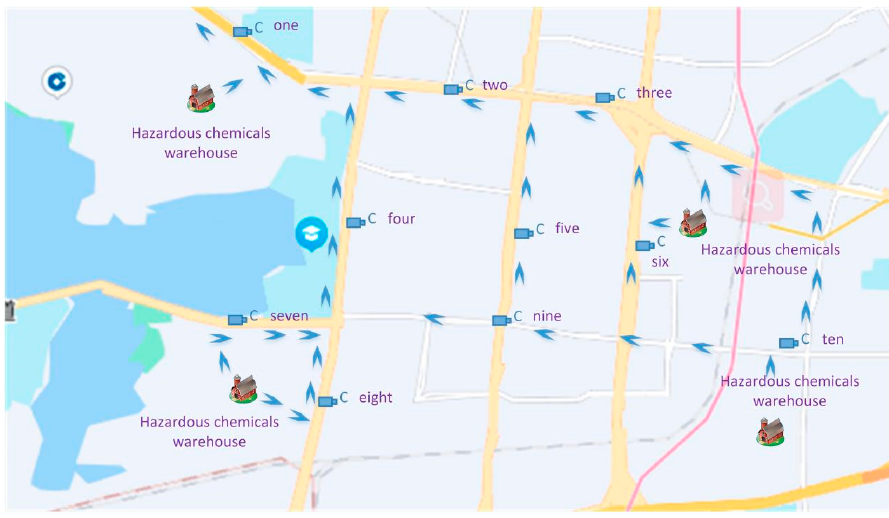
Figure 9. Four hazardous goods warehouses and ten CCD cameras on ten locations.